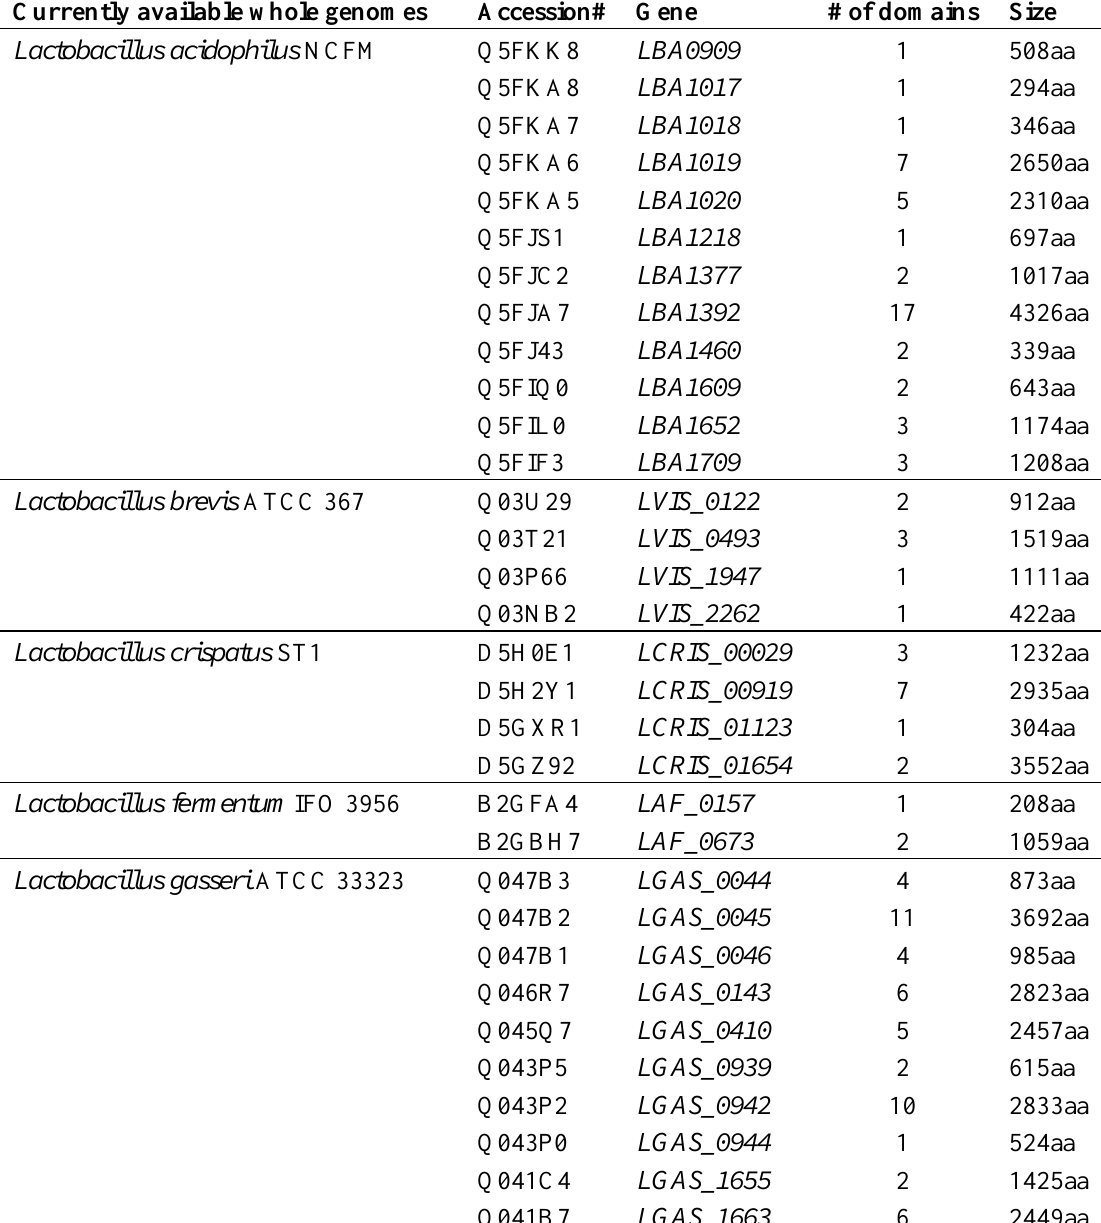
Table 3. MucBP domain containing sequences in available Lactobacillus